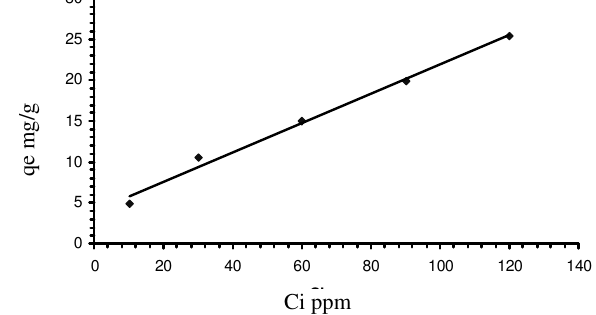
Figure 5. Effect of initial copper concentration on q